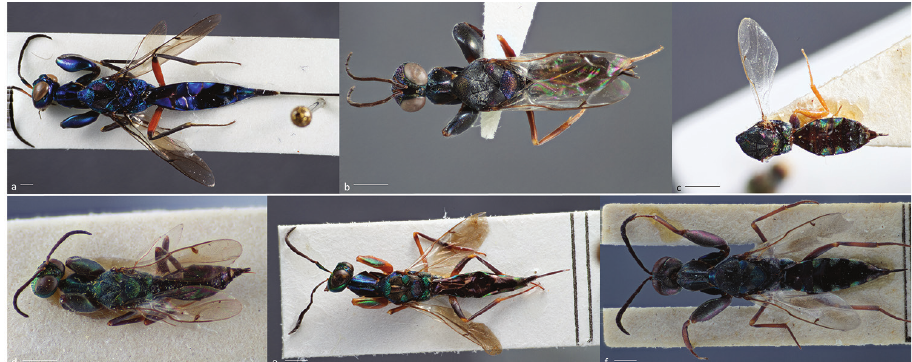
Figure 3. Habitus (dorsal) II a O. gracilis Westwood (imaged specimen: OGr01; ovipositor not visible in full length) b O. heikewernerae sp. n. (OHe01, holotype) c O. hoggarensis Hedqvist (OHo02, para- type) d O. leibnizi sp. n. (OLe01, holotype) e O. longicollis (Cameron) (OLo01) f O. madegassa Bouček (OMad01, holotype). Scale bars: 1